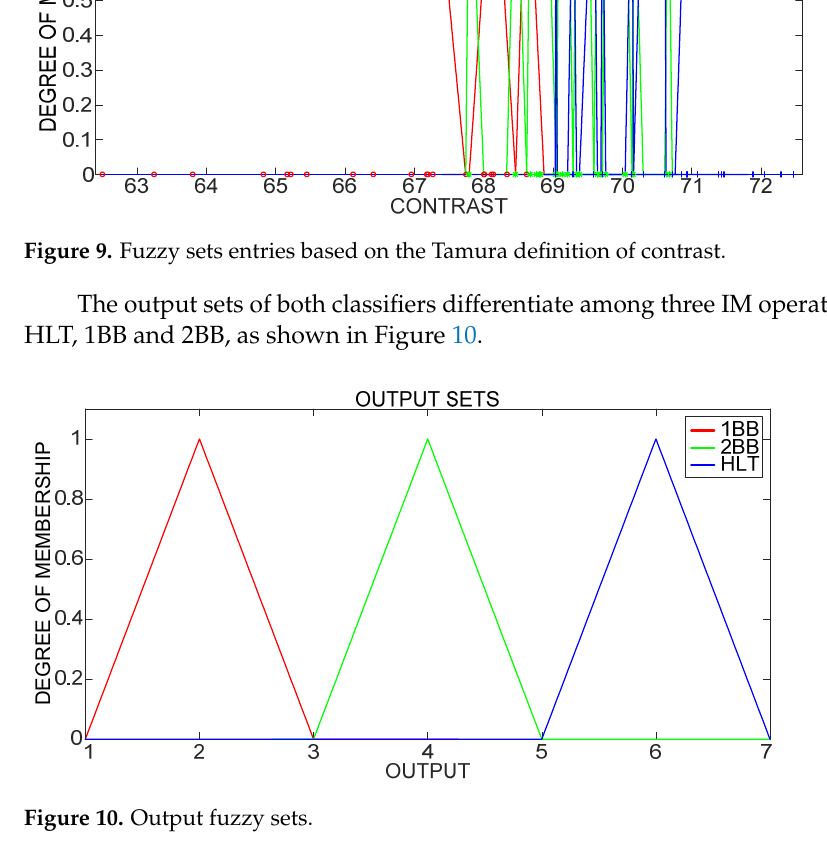
Figure 10. Output fuzzy sets.